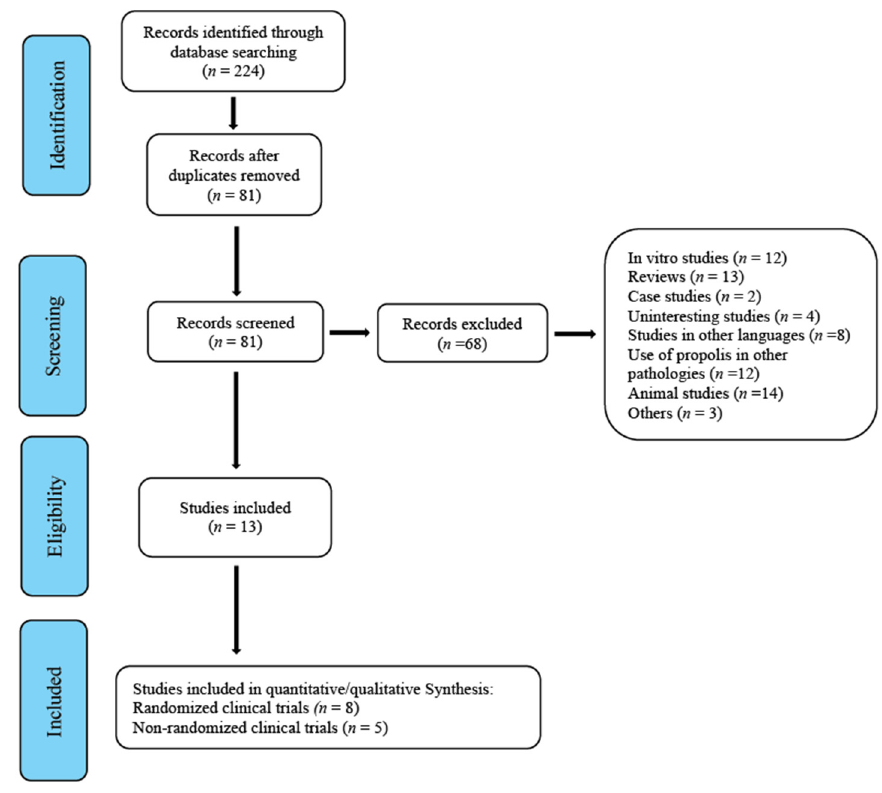
Figure 1. Flowchart.